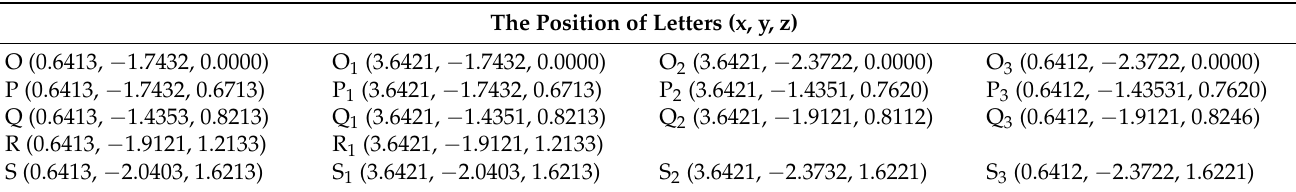
Table 3. The corresponding coordinates of each letter in the display and control console.